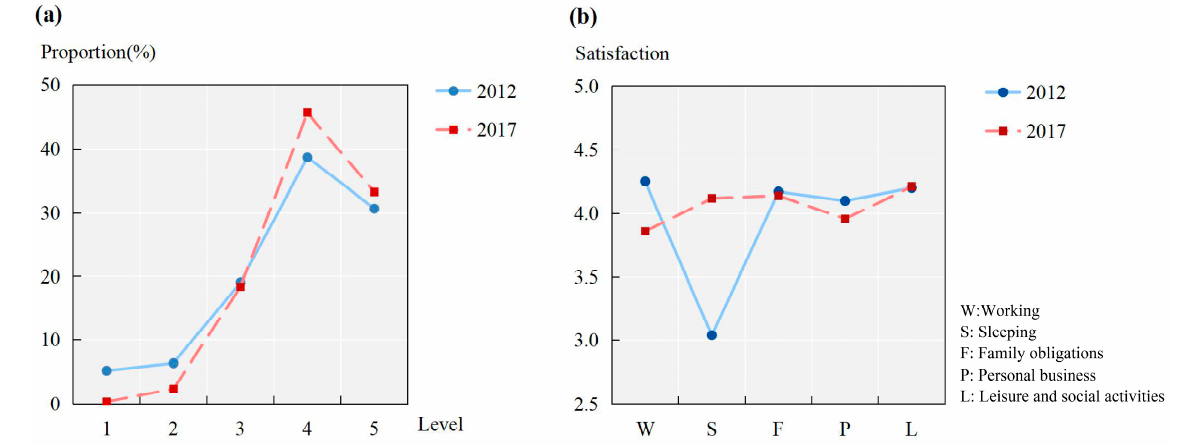
Figure 2. ( a ) Proportion of activity satisfaction and ( b ) average satisfaction level for different activity types.